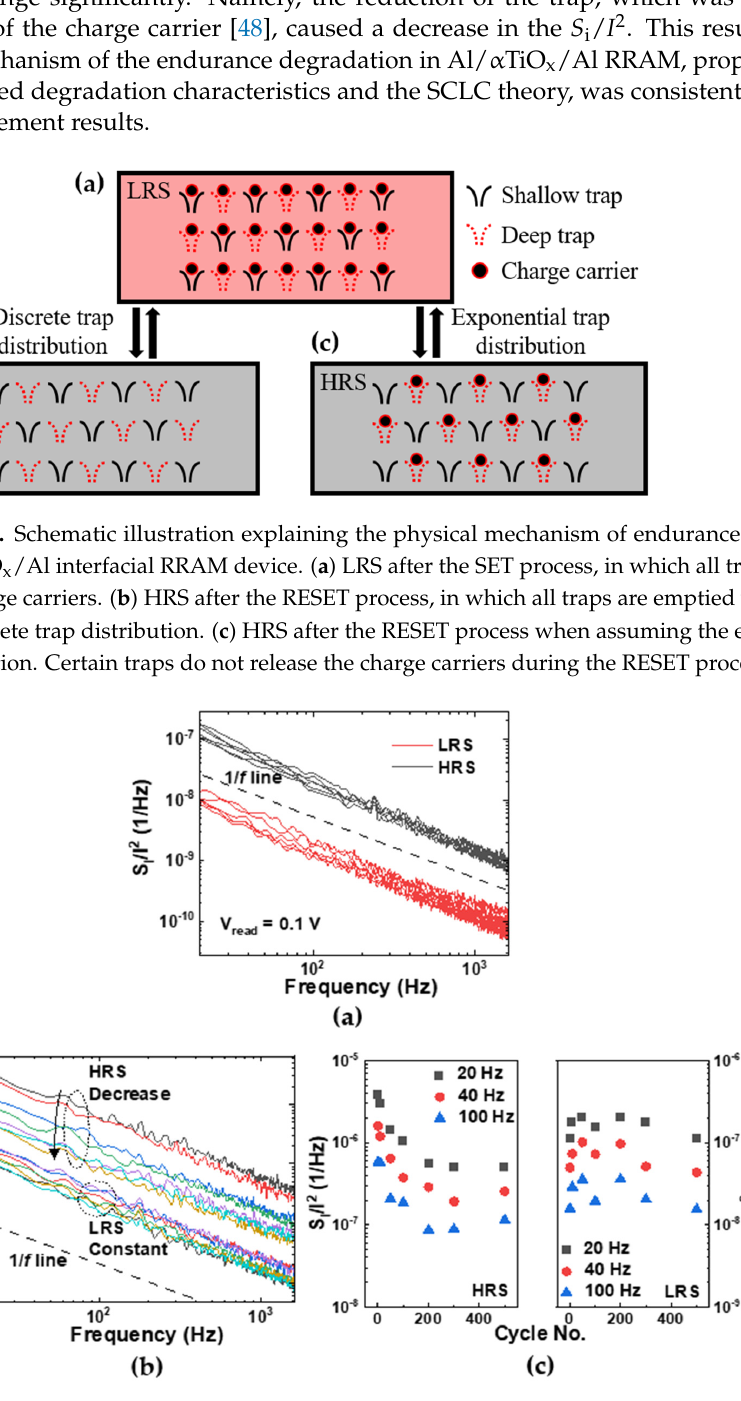
Figure 5. ( a ) The S i / I 2 for several devices in both the HRS and LRS at 0.1 V. ( b ) The S i / I 2 in both the HRS and LRS according to the RS cycle at the same read bias. ( c ) The change in the S i / I 2 according to the RS cycle in both the HRS (left) and LRS (right) at the frequencies 20, 40, and 100